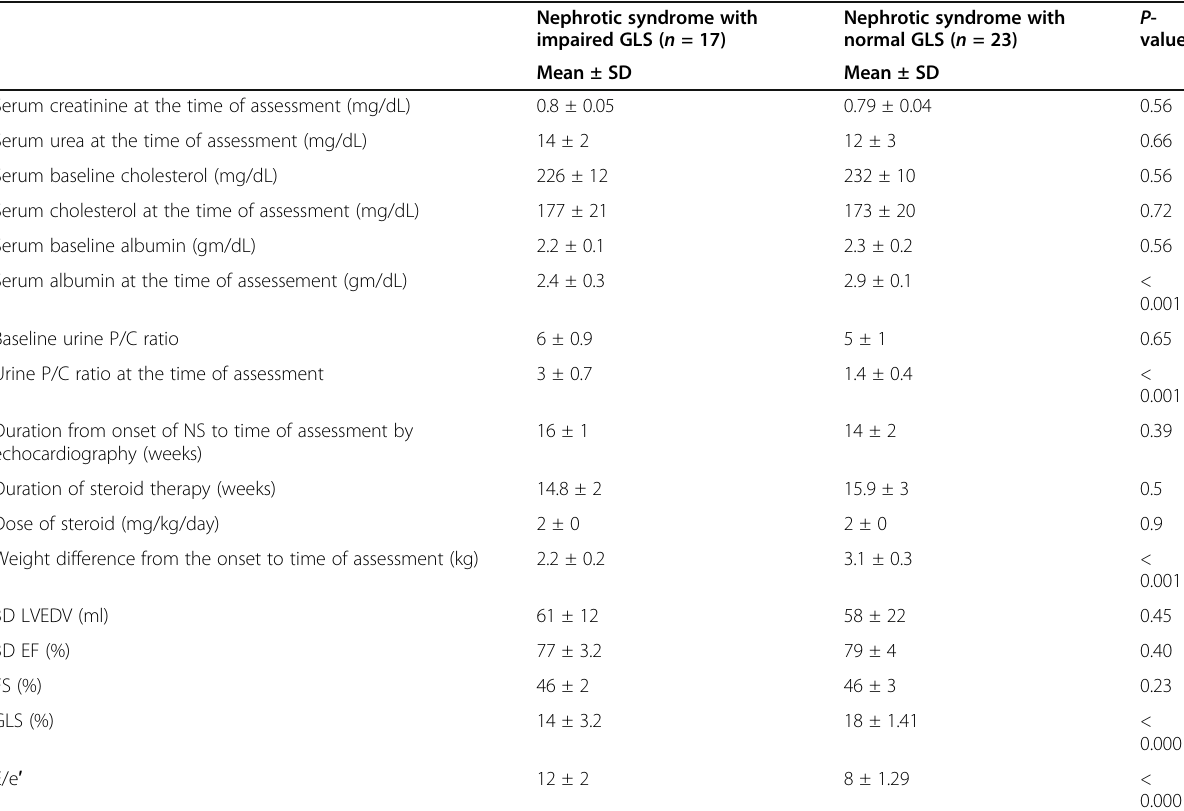
Table 3 Duration of nephrotic syndrome, steroid therapy, laboratory, and echocardiographic data in cases with systolic dysfunction vs. cases